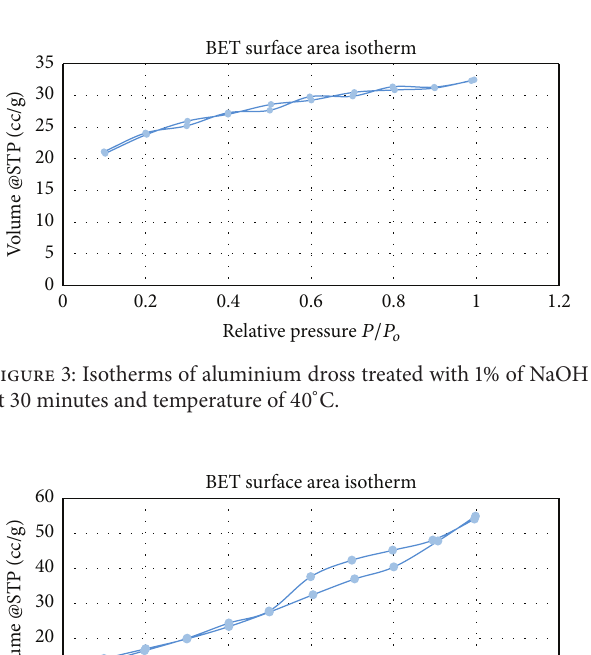
Figure 1: Isotherms of raw aluminium dross.